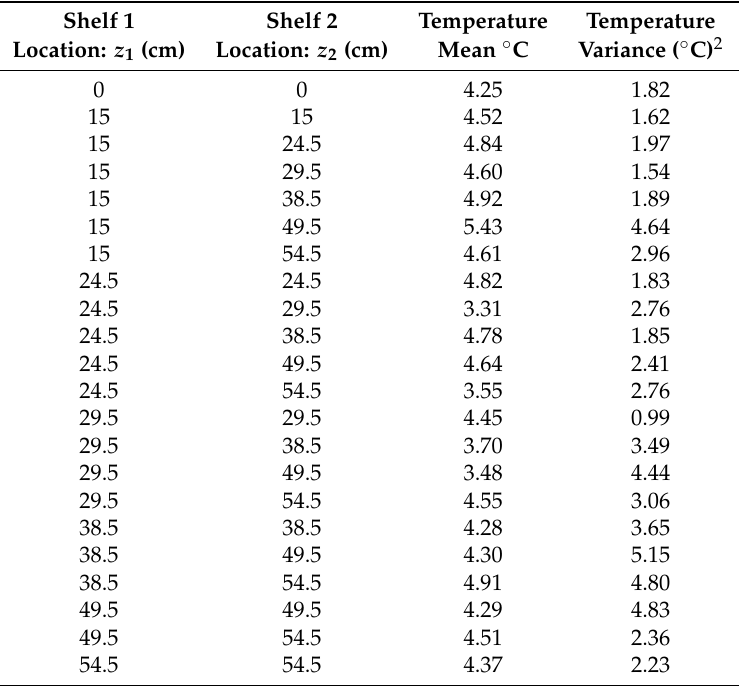
Figure 2. Shelf position and manipulated spacing. Table 2. Shelf